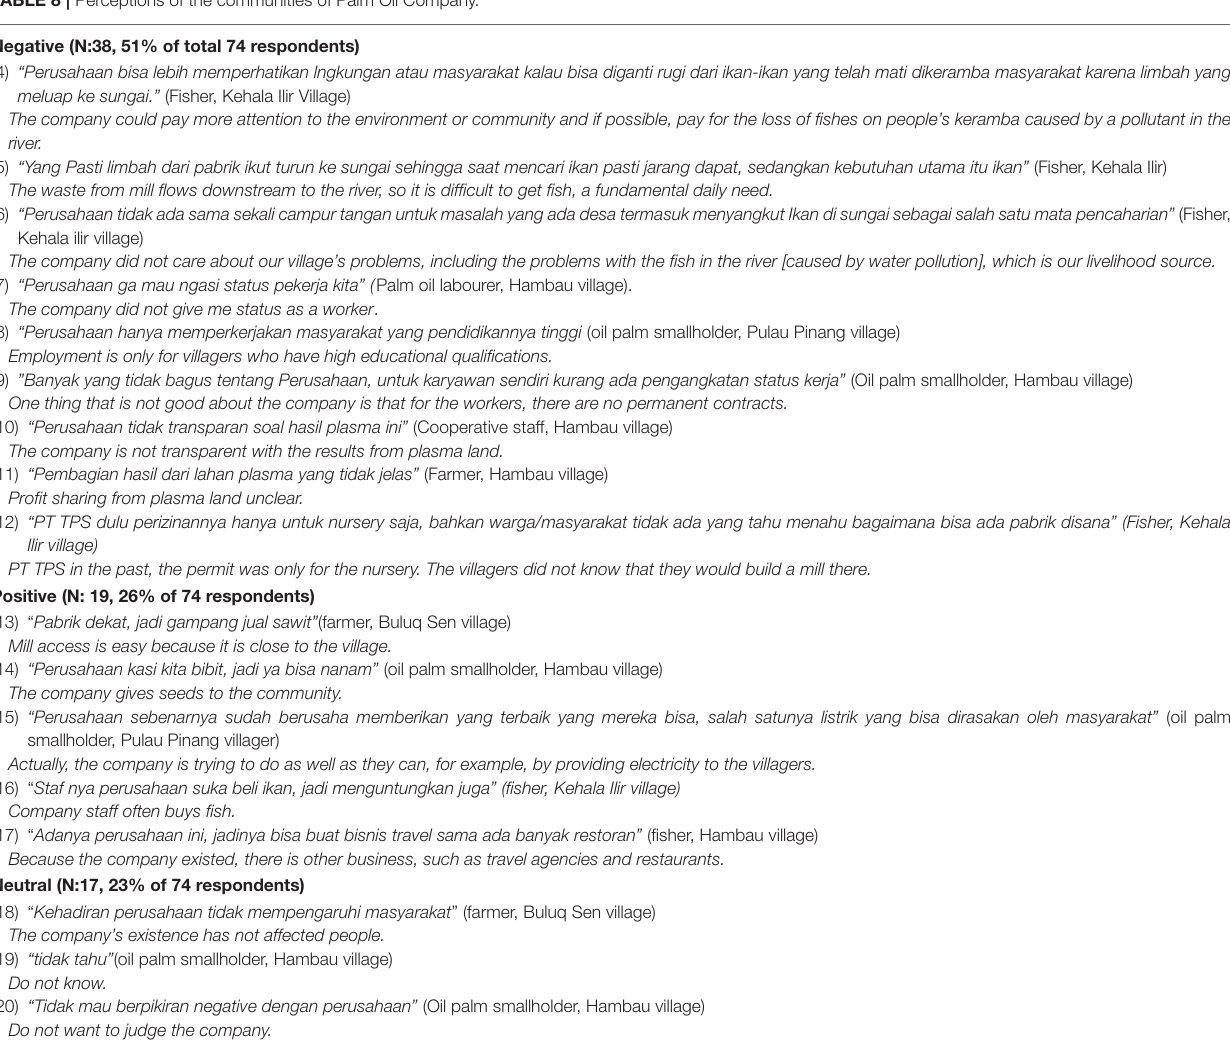
TABLE 8 | Perceptions of the communities of Palm Oil